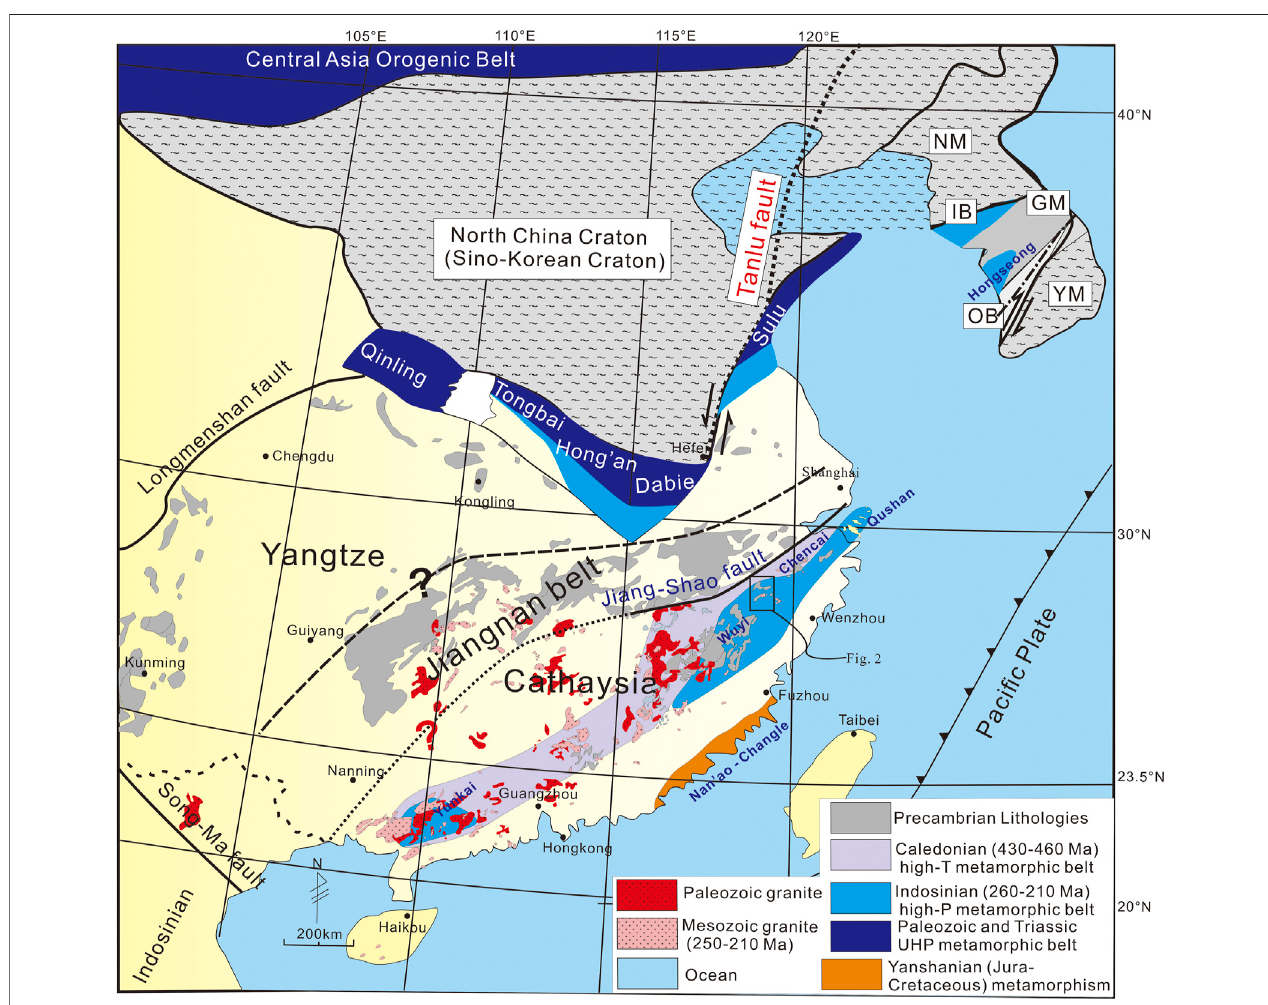
FIGURE1| Simpli fi edgeologicalmapshowingmajorpartsoftheeastEurasiacontinent,withemphasizeoftheSCB.NM-NangrimMassif;IB-ImjingangBelt;GM- Gyeonggi Massif; OB- Okcheon Belt; YM- Yeongnam Massif. The map is modi fi ed after Oh and Kim (2021), Zhai et al. (2016) and Zhao et al. (2019., 2020).